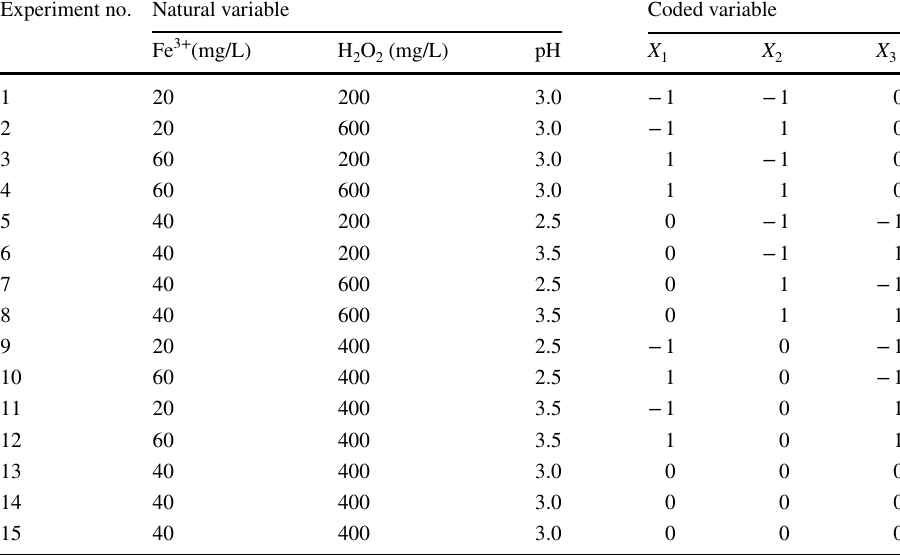
Table 2 RSM for the three Experiment no. Natural variable Coded experimental variables in coded units and corresponding natural values